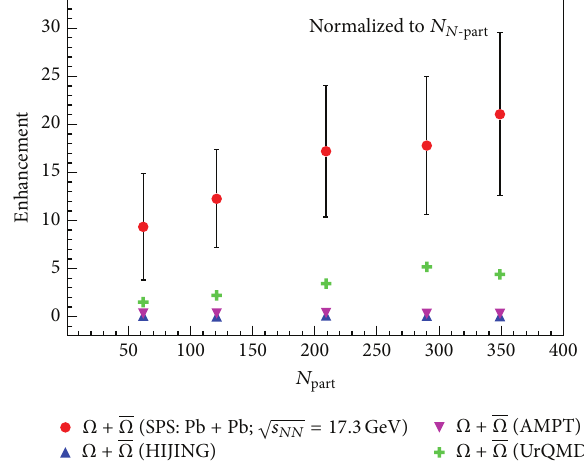
Figure 5: 𝑁 𝑁 -normalized enhancements of Λ as a function of -part collision centrality for Pb + Pb collisions at √𝑠 𝑁𝑁 = 17.3 GeV are compared with HIJING, AMPT, and UrQMD models at midrapid- ity.